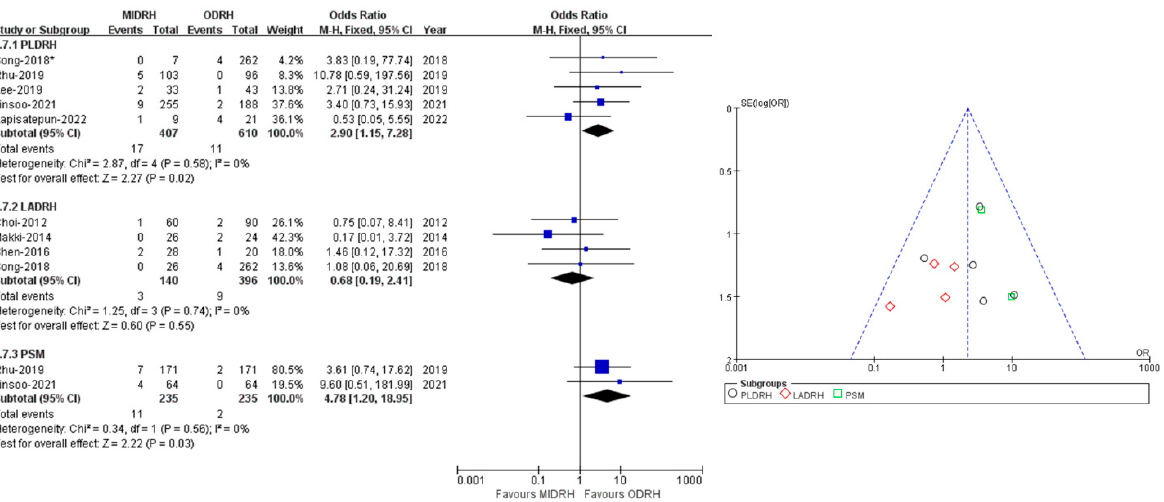
Figure 8. Forest plot comparison of MIDRH versus ODRH for postoperative transfusion